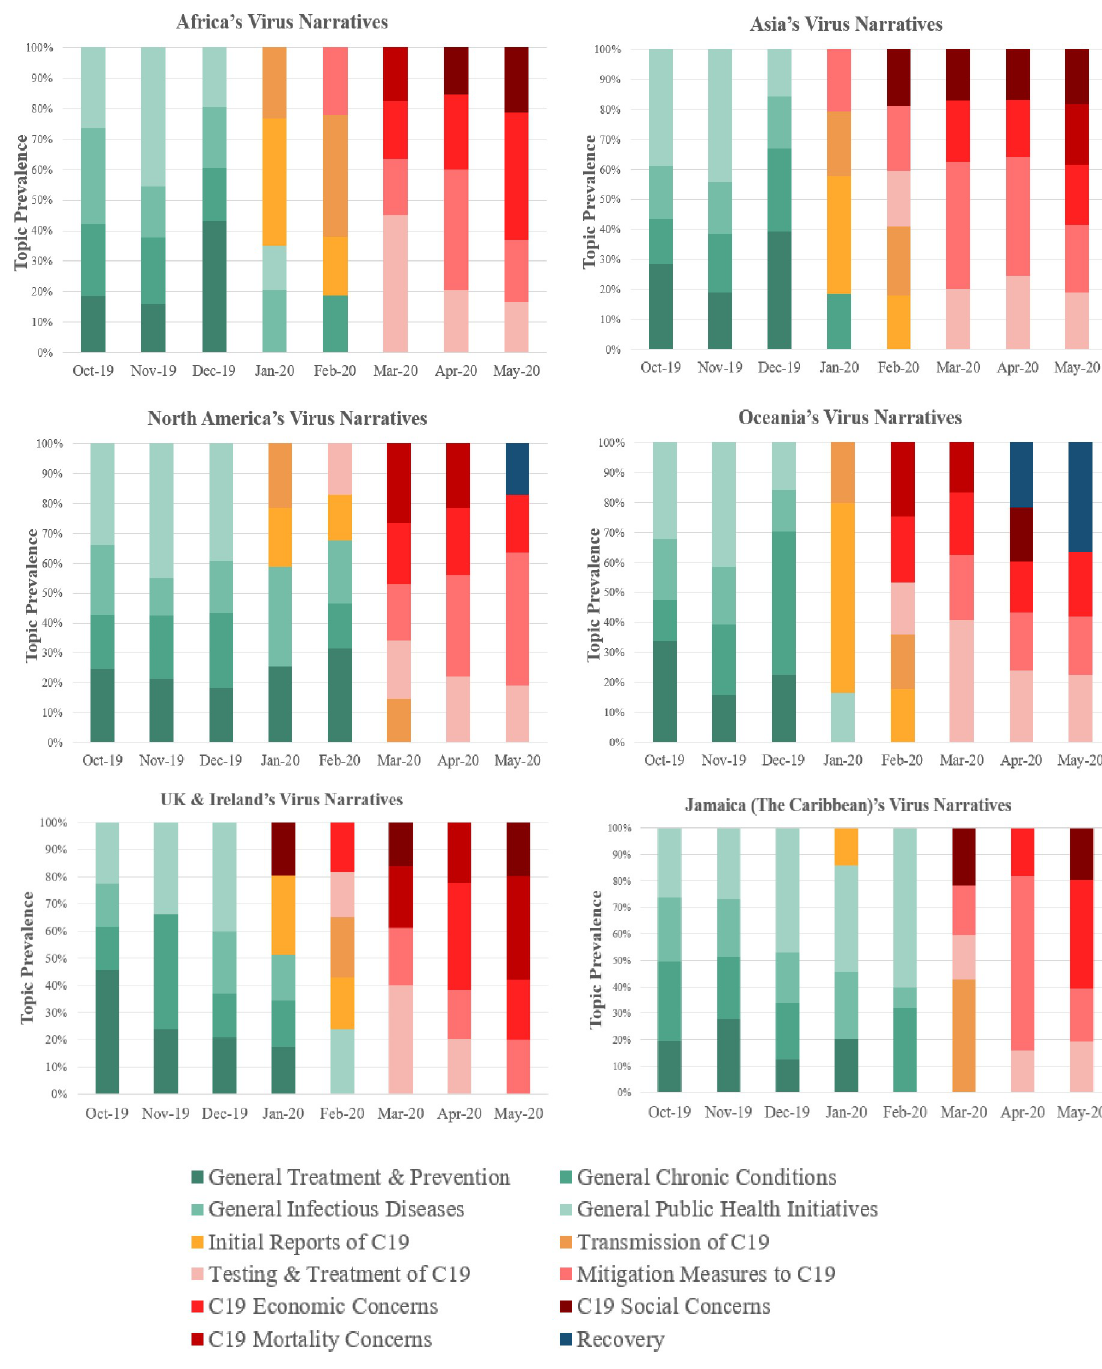
Fig 4. Content of regional Covid-19 narratives across six